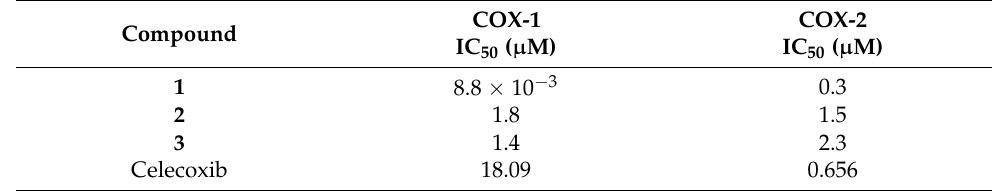
Table 3. In vitro Cyclooxygenase inhibitory activity of compounds 1 – 3